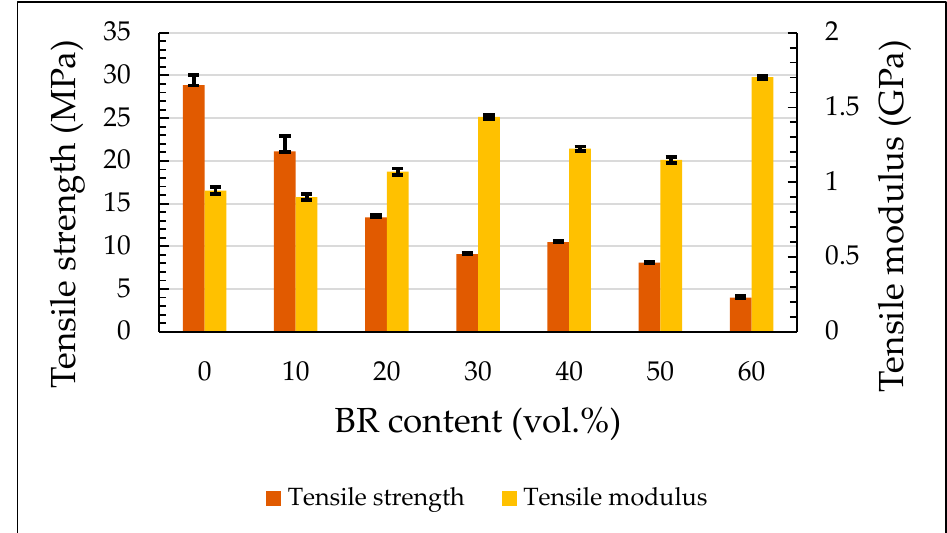
Figure 8. Effect of BR vol.% on the tensile strength and modulus. The relatively higher values of tensile strength at lower BR content can be due to strong interfacial bonding, better filler dispersion in the matrix, and lack of voids or po- rosity. By contrast, the reduction in tensile strength with the increase in BR content may be attributed to the lower efficiency of stress transfer between the BR particle–polyester interface due to the weak adhesion force at the interface, direct contact between particles, and the presence of voids or porosity. These were confirmed by the SEM micrographs of 20 and 60 vol.% BR (Figure 9a,b, respectively); the BR particles were well embedded in the polyester matrix. Moreover, the degree of detachment between the filler particles and the polymer, which causes the formation of small voids or gaps, was at the minimum for 20 vol.% BR. This demonstrates the strong compatibility of BR particles with the polyester matrix reflected by the significant enhancement in tensile strength at 20 vol.% BR com- pared with that at 60 vol.% BR. SEM images show some kind of particles agglomeration that is expected to increase with increasing filler content.